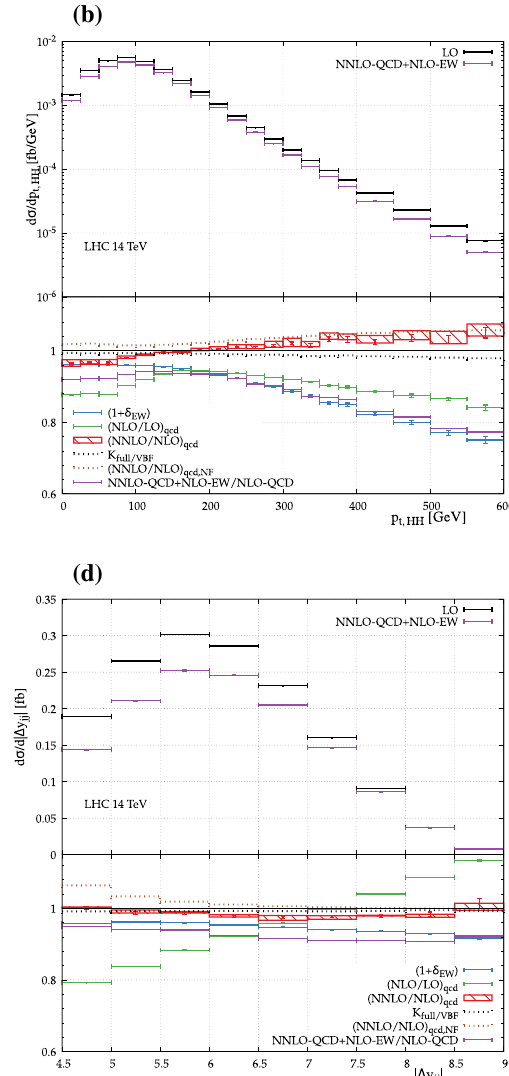
ity difference between the two hardest jets (bottom right). The upper panel shows the absolute contributions at NNLO QCD + NLO EW and the LO prediction. The lower panel shows the relative corrections. The bands denote the envelope of the QCD scale